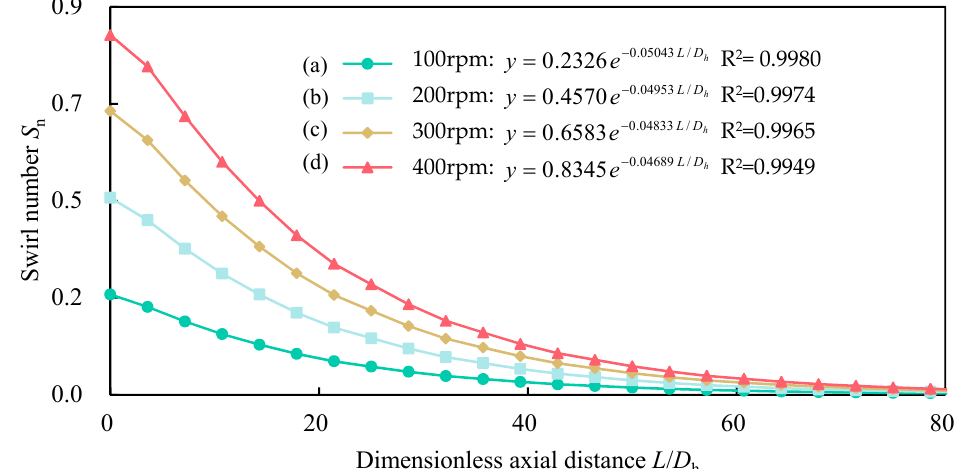
Figure 3. The effect of rotational speed on the swirl number: ( a ) 100 rpm; ( b ) 200 rpm; ( c ) 300 rpm; ( d ) 400 rpm.